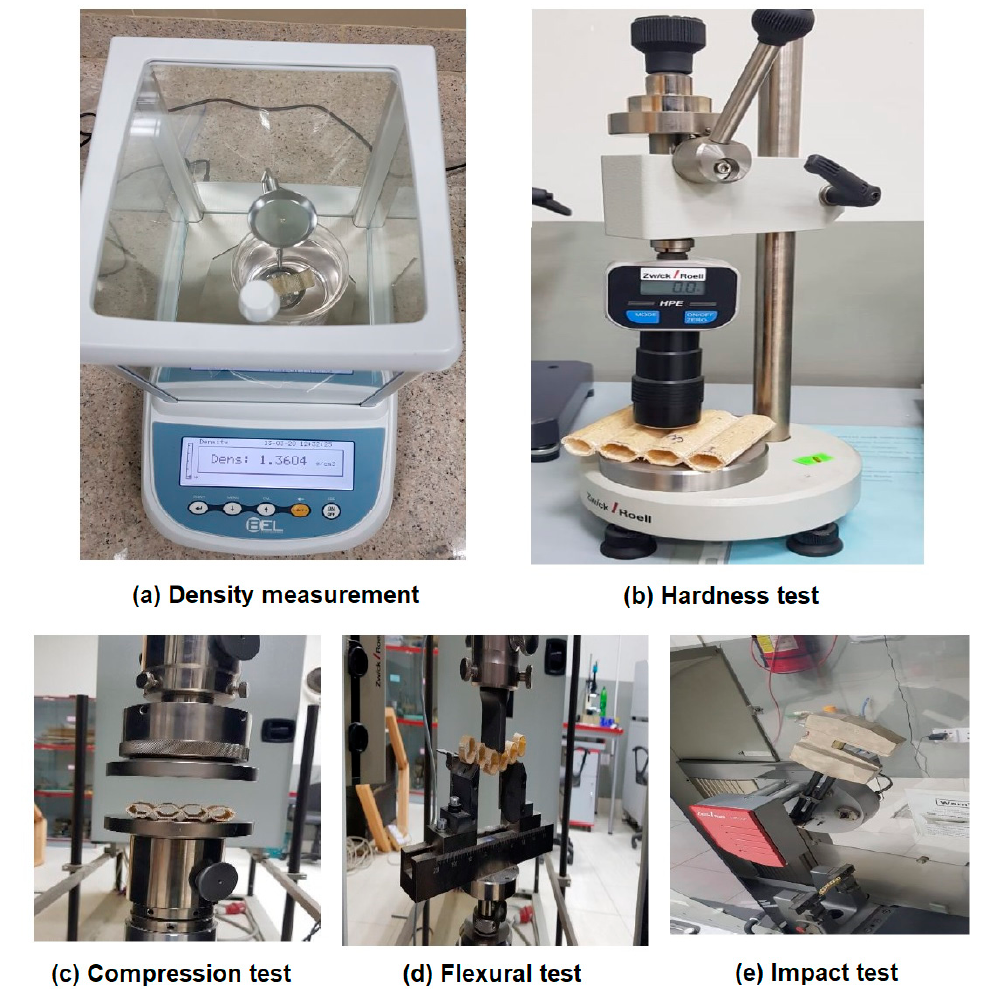
Figure 4. Physical and mechanical characterization of manufactured hollow composite samples.